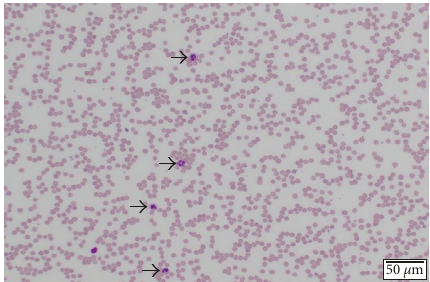
Figure 1: Unremarkable neutrophils in the background of anemia. Absolute leukopenia with absolute neutropenia. Black arrows show a decreased number